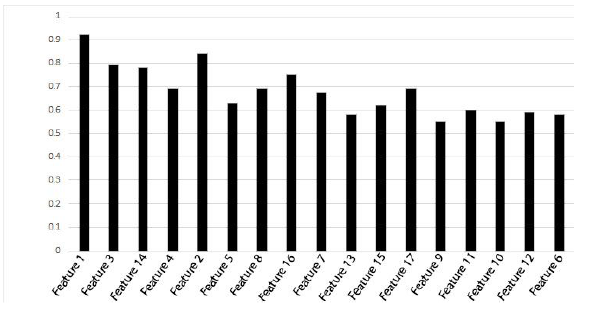
Figure 3. Area under ROC curve for individual